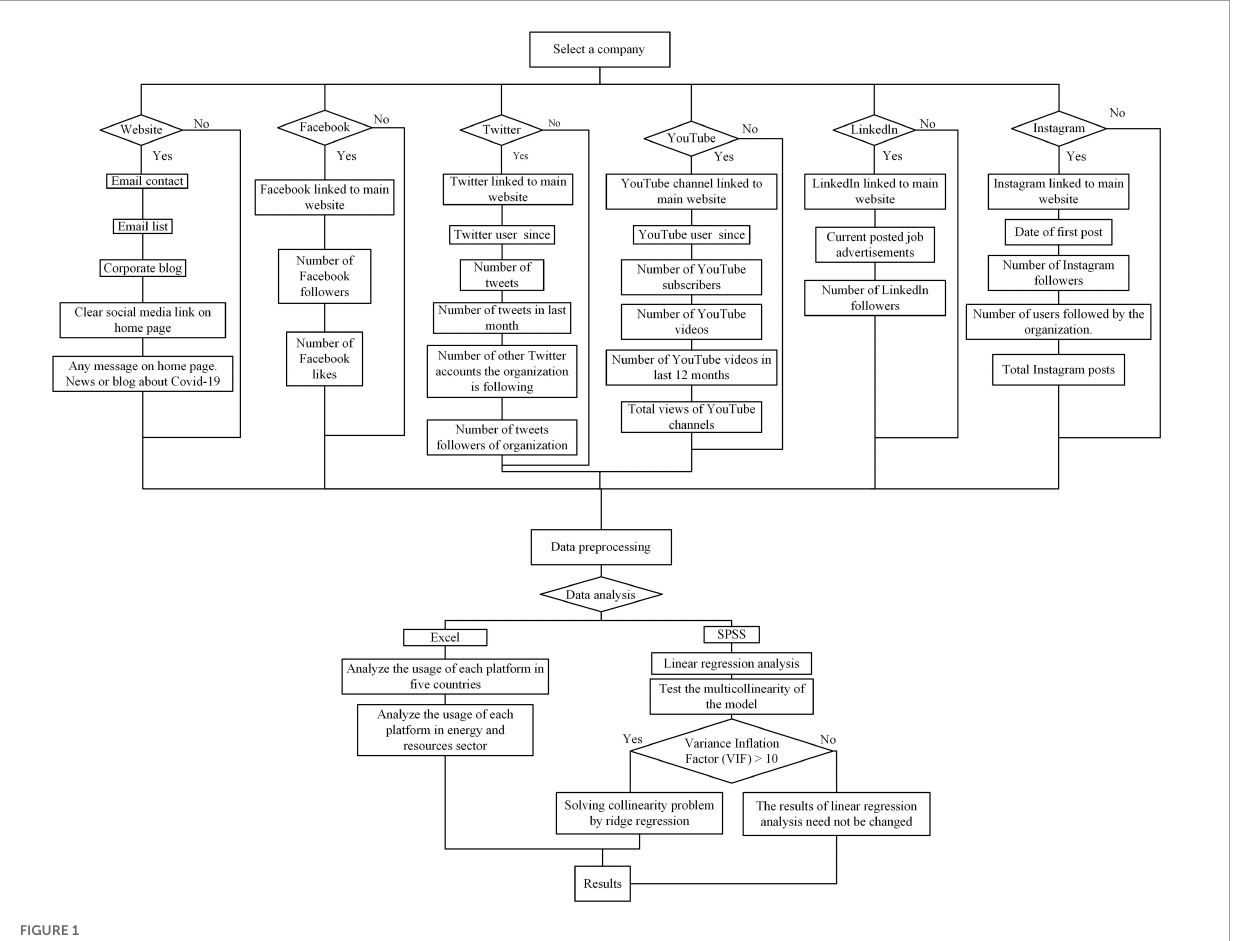
FIGURE1 Schematic of the exploratory research design used in this study.